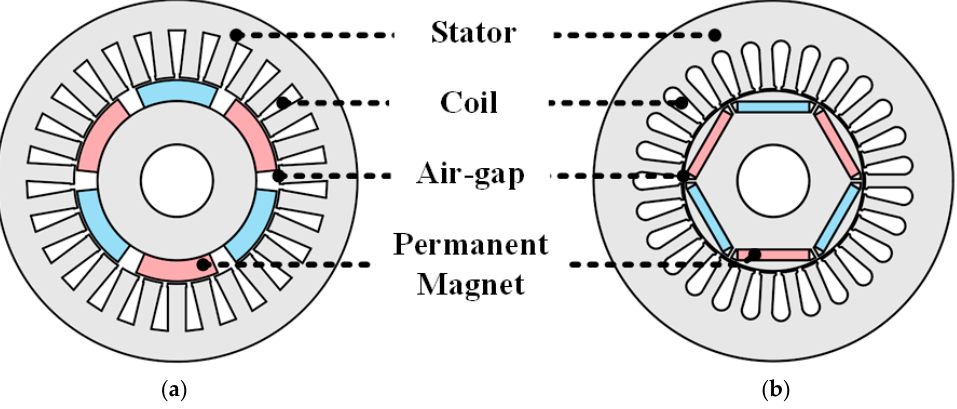
Figure 1. Required torque–speed curve of the motor for the compressor applications .